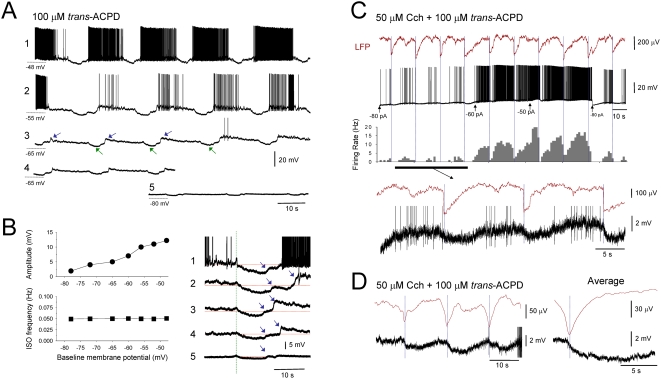
Response of the ISO to changes in membrane polarization and the presence of the ISO in LFP recordings.A. Intracellular recording of an ISO in a TC neuron in the LGN at different levels of steady current. Note that although ISO is mainly sculpted by long-lasting rhythmic hyperpolarizing potentials (green arrows in 3) it also involves depolarizing events (blue arrows in 3) (See also Figs. S5B and S5C). B. Plots showing that the amplitude (top) of the long-lasting hyperpolarizing potentials exhibited by the neuron in A is reduced as the cell is hyperpolarized but that the frequency (bottom) of the ISO is unaltered at ∼0.05 Hz. The traces to the right show enlarged examples of the long-lasting hyperpolarizing potentials in A (aligned at their start by the green dotted line at different levels of membrane polarization, red dotted line indicates the baseline membrane potential; numbers correspond to the traces in A). Note again the presence of additional depolarizing events (blue arrows). C. Simultaneous LFP and intracellular TC neuron recording of an ISO at ∼0.06 Hz (dark red trace) in the MGN (black trace) at different levels of steady injected current as indicated. The corresponding firing rate histogram is shown immediately below. Shown further below is an enlarged section of the recording (as indicated, action potentials truncated) illustrating that the negative peaks of the LFP (blue vertical lines) are coincident with a hyperpolarization and an accompanying suppression in firing in the TC neuron. B. Additional simultaneous LFP and intracellular TC neuron recording of an ISO at ∼0.083 Hz (red trace) obtained in the LGN. The traces to the right show the LFP negative peak-triggered averages for the LFP and membrane potential. (10 µM SR95531 and 10 µM CGP54626 were present for the recording shown in C).